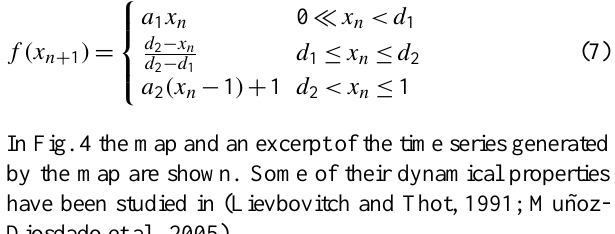
Figure 4. Liebovitch and Thot map and an excerpt of the generated time series.